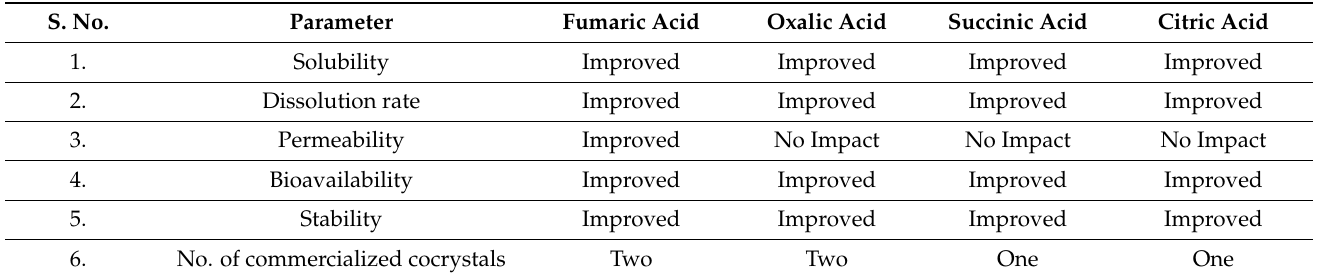
Table 12. Role of coformers on the physicochemical properties of